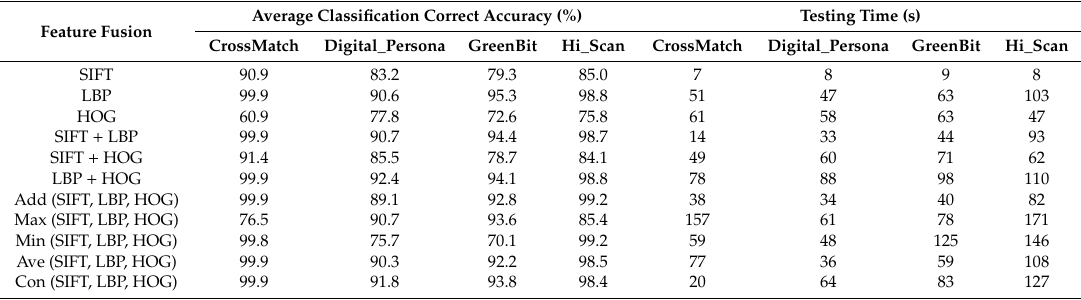
Table 7. Average classification accuracy and testing time of di ff erent feature fusions in the LivDet 2015 fingerprint